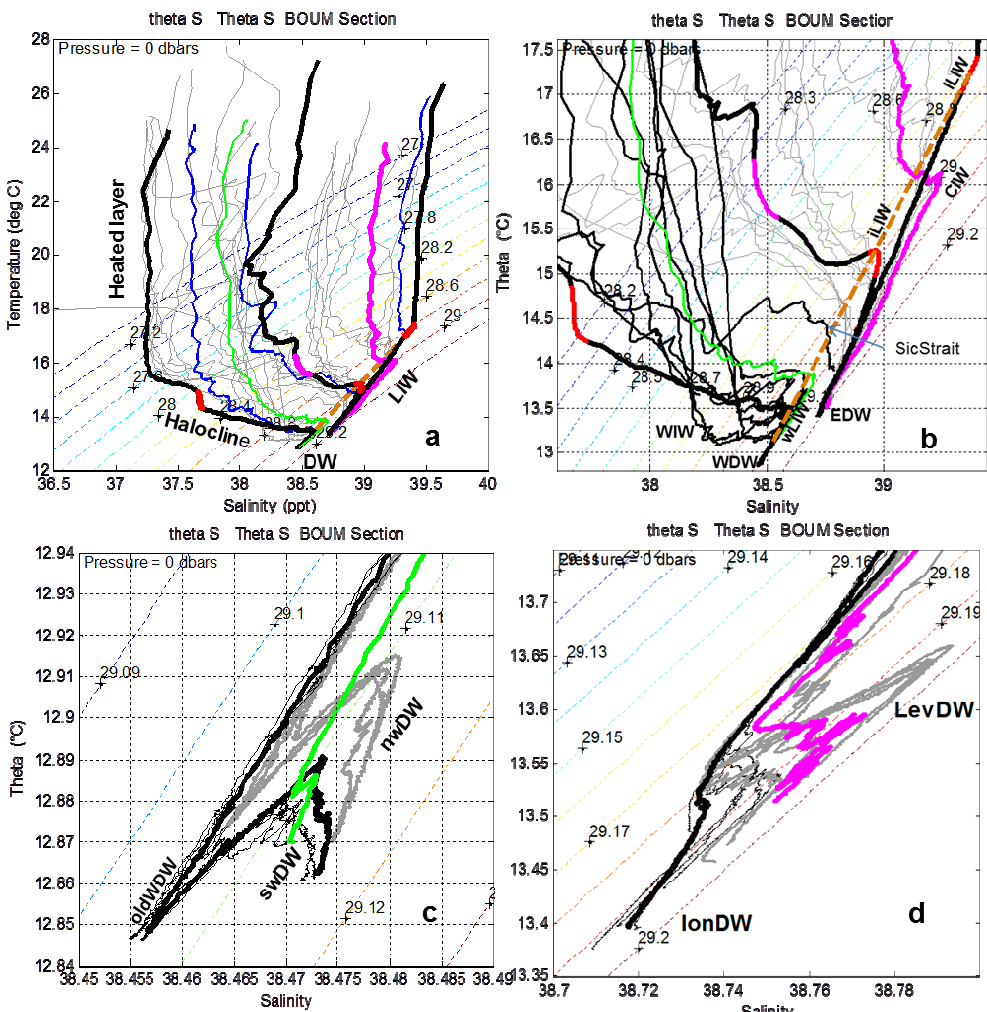
Fig. 2. θ − S diagrams for all the 30 deep casts of the BOUM section. (a) Full range, with indications of heated layer, halocline, LIW layer and deep layer, DW (see text). (b) Zoom in order to show intermediate waters using θ < 17.4 ◦ C and S > 37.5. WIW: winter intermediate water in the western MS. lLIW, iLIW wLIW aligned along the dashed straight ochre line represent the Levantine, Ionian and western LIW, respectively. CIW: Cretan intermediate water. (c) Zoom for the western Mediterranean deep waters; oldWDW, swDW and nwDW stand for old western, southwestern and northwestern deep waters. All these deep waters were thought to have formed in northwestern MS, but the two latter after 2005–2006. (d) Deep layer in the eastern MS; LevDW was observed in the Levantine basin and IonDW in the Ionian basin. Lines: The thick black lines from left to right on panel (a) represent the LD stations A, B and C located at the centre of the eddies. The blue lines represent the closest SD stations investigated outside each eddy. The mauve thick line indicates the Ierapetra eddy (station 6), and the green thick line, the SD station located south of Sardinia (SD station 20). All other stations were drawn in thin grey in (a) , in middle black for the western MS with SD station 18 (771dbars deep) near the Sicilian sill identified as SicStrait in (b) . The fine black and middle grey correspond to θ − S profiles in the south and northwestern MS in (c) and in the Ionian and Levantine basins on (d) , respectively. The θ − S ) is superimposed to thick black part at the depth ranges of the pycnostad found for each eddy A, B, C (see Table 1, D E to D E TopAno MaxAno lines in thick red (panels (a) and (b) ). For eddy B, the B surf pycnostad was drawn in thick